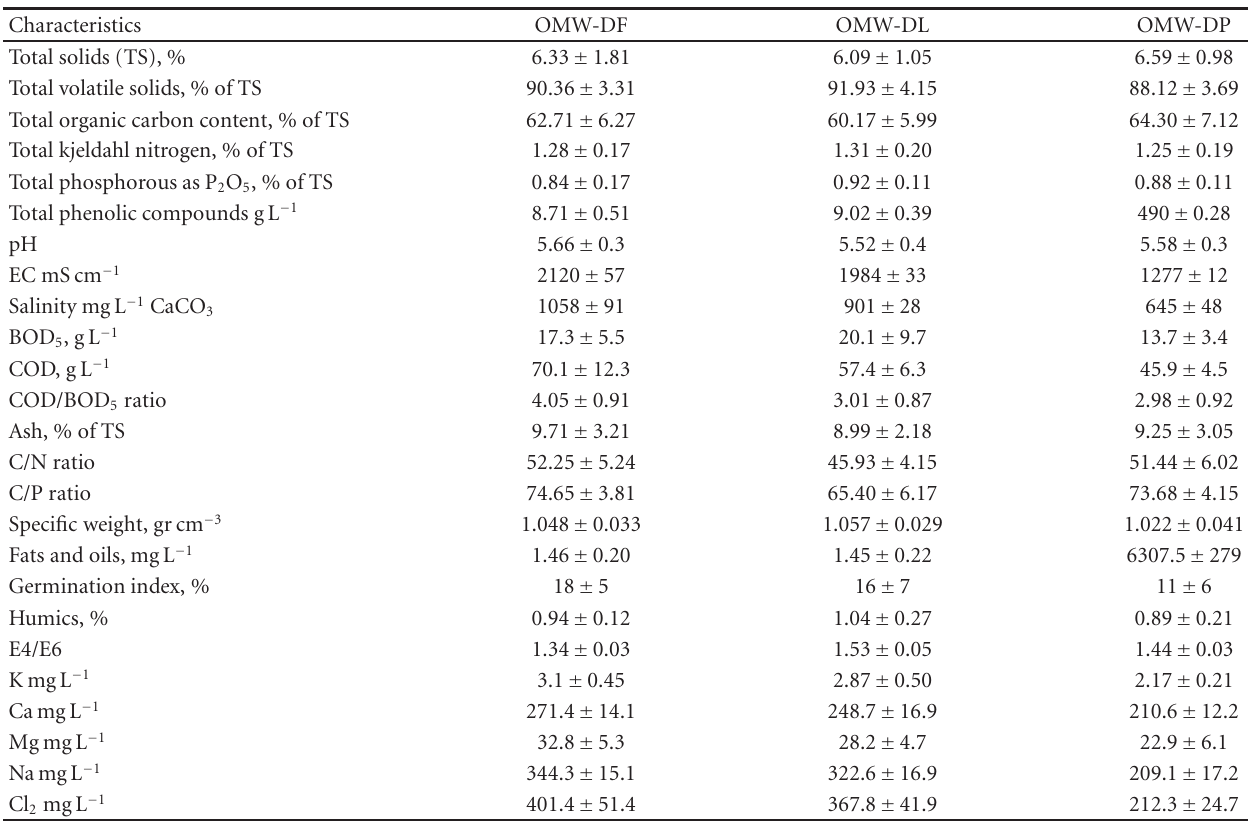
Table 2: Composition of the olive mill